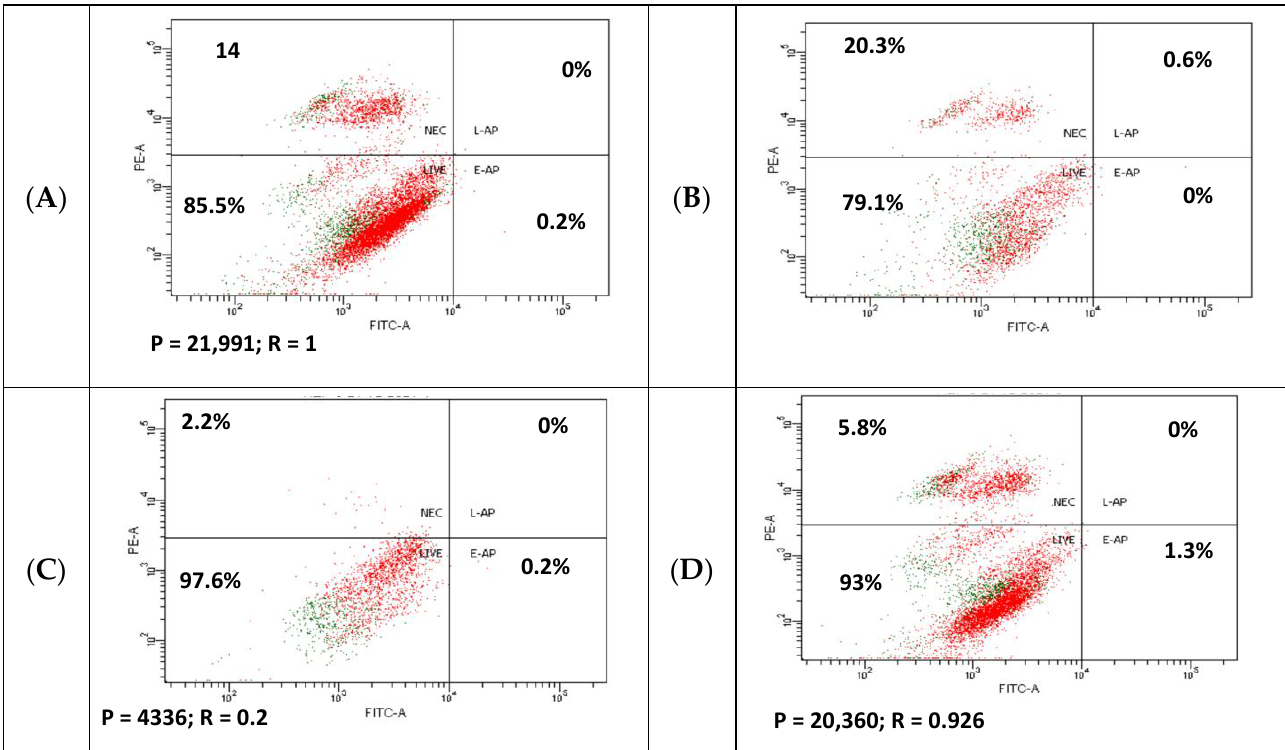
Figure 2. HepG2 staining with Annexin V/7-PI; control ( A ); treated with 30 µ g/mL 6-MP ( B ); 5 µ g/mL 6-MP loaded with positive charge liposome [F1] ( C ); and free positive charge liposomes [F3] ( D ).